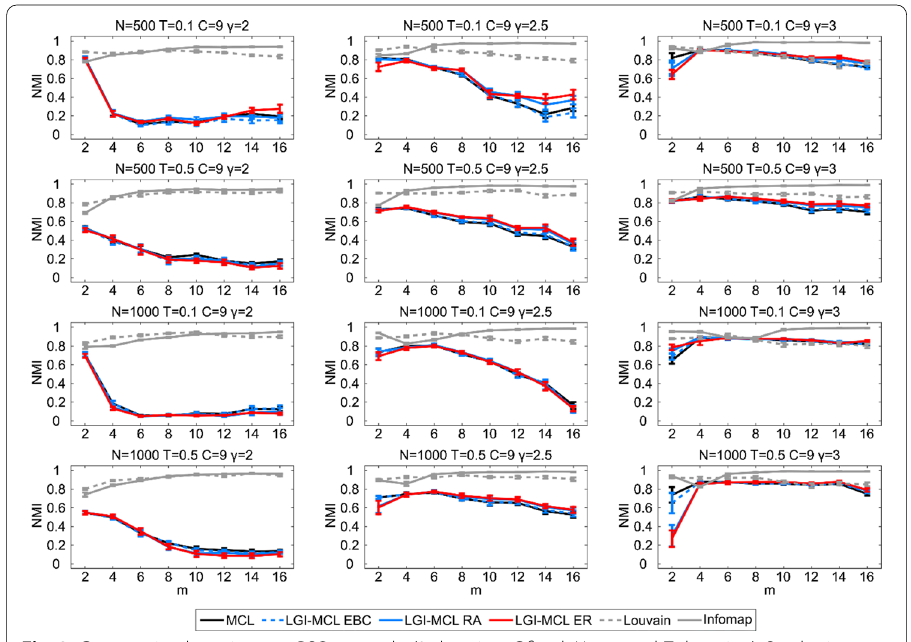
Fig. 3 Community detection on nPSO networks (3rd setting: C fixed; N , γ, m and T changing). Synthetic networks have been generated using the nPSO model with parameters N 2.5, 3] (power-law degree distribution exponent), m T [0.1, 0.5] (temperature, inversely related to the clustering coefficient) and C = For each combination of parameters, 10 networks have been generated. For each network the community detection methods have been executed and the communities detected have been compared to the annotated ones computing the Normalized Mutual Information (NMI). The plots report for each parameter combination the mean NMI and standard error over the random repetitions and show that MCL improves its performance with the increase of γ for middle and large size